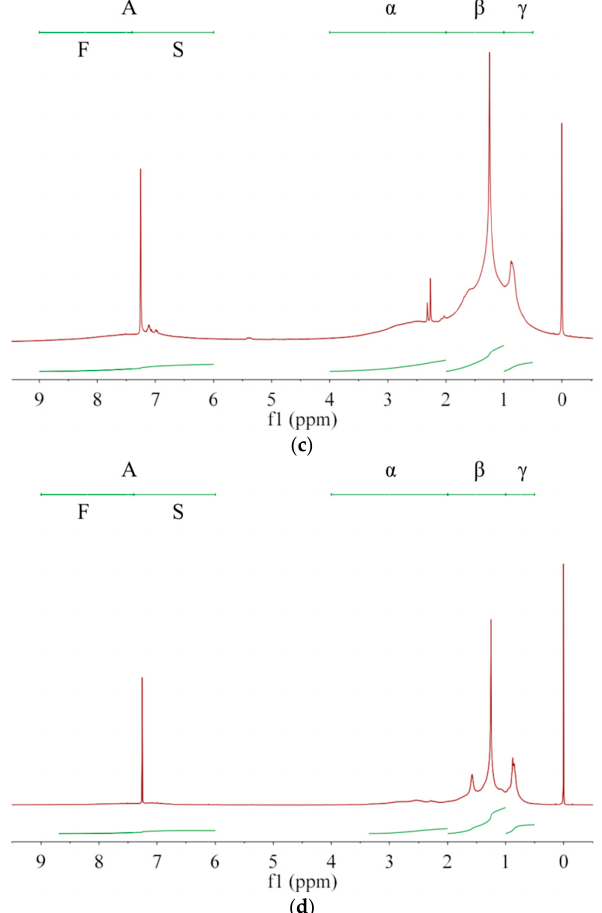
Figure 2. The 1 H-NMR spectra for ( a ) asphaltene A1, ( b ) asphaltene A2, ( c ) asphaltene A3 and ( d ) base asphalt. Protons are divided into A, α , β , and γ categories while the category A includes protons on single (S) and fused (F) aromatic rings. Table 5. Calculated values for the average molecular structure of the extracted asphaltenes (A1, A2 and A3) and the base asphalt according to their NMR spectra 1 .